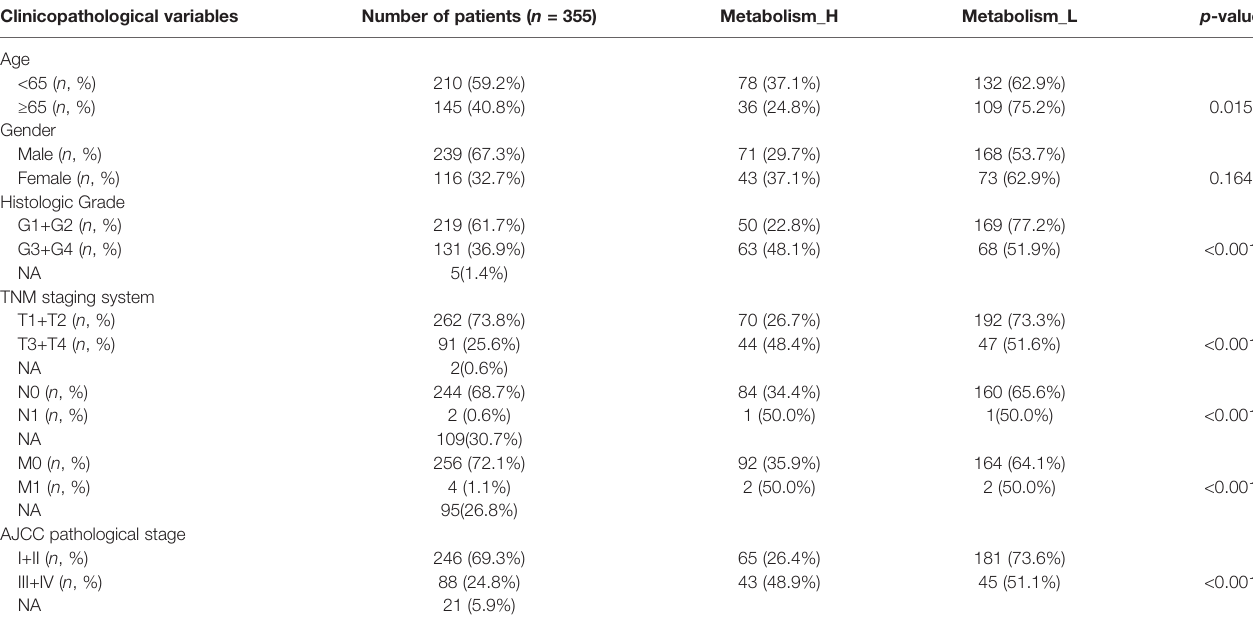
TABLE 1 | Correlations between risk score of the metabolism-related pathways classi fi er with overall survival and clinicopathological characteristics in the TCGA-LIHC cohort. Clinicopathological variables